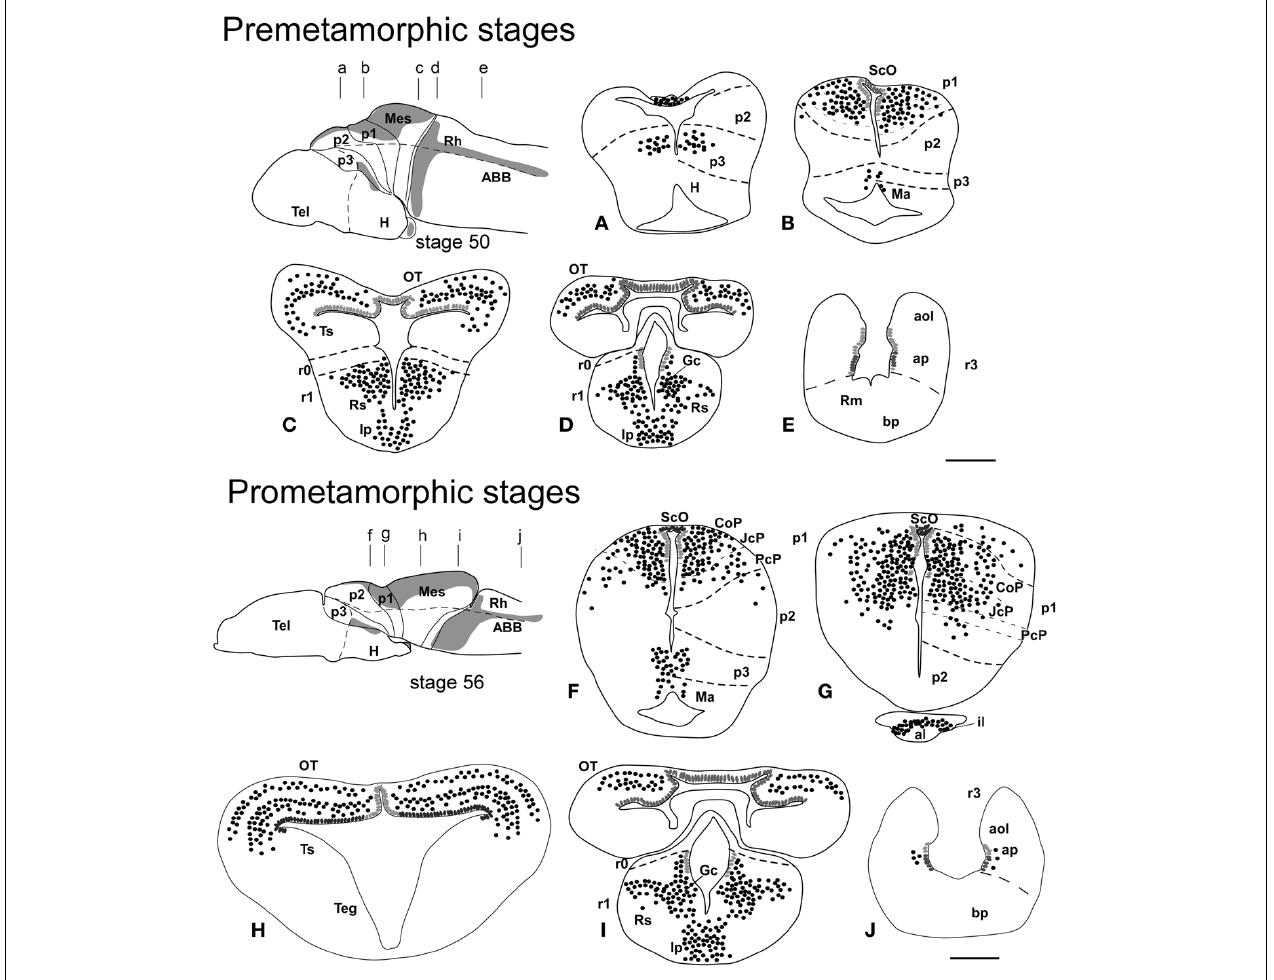
FIGURE 2 | Schematic drawings of transverse sections through the brain of Xenopus laevis at premetamorphic stage 50 (A–E) and prometamorphic stage 56 (F–J) showing the distribution of Pax7